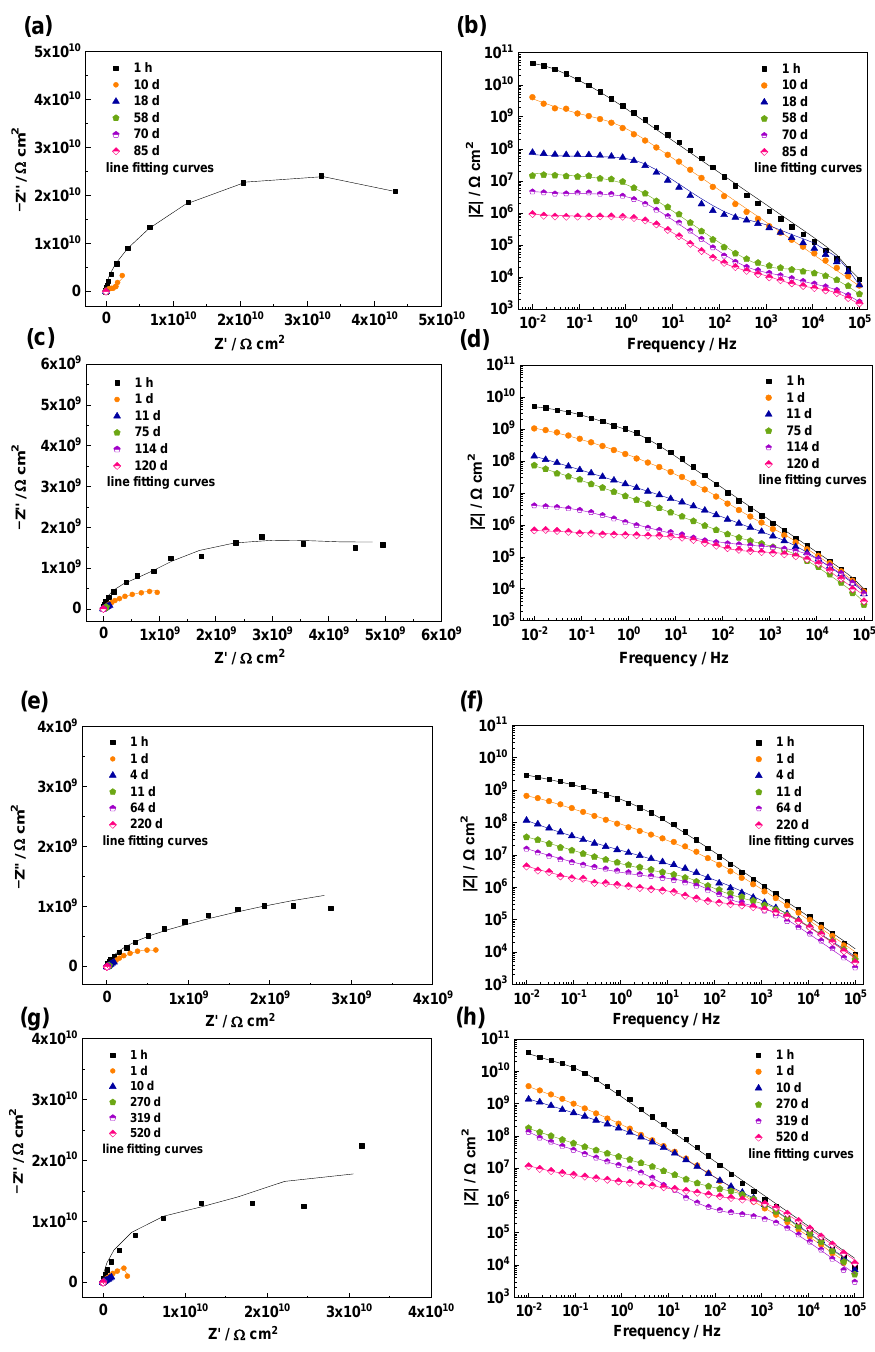
Figure 4. EIS spectra of the coated samples containing different contents of CeTar in 3.5% NaCl solution: ( a , b ) 0 wt% CeTar; ( c , d ) 1.5 wt% CeTar; ( e , f ) 3 wt% CeTar; ( g , h ) 5 wt% CeTar.